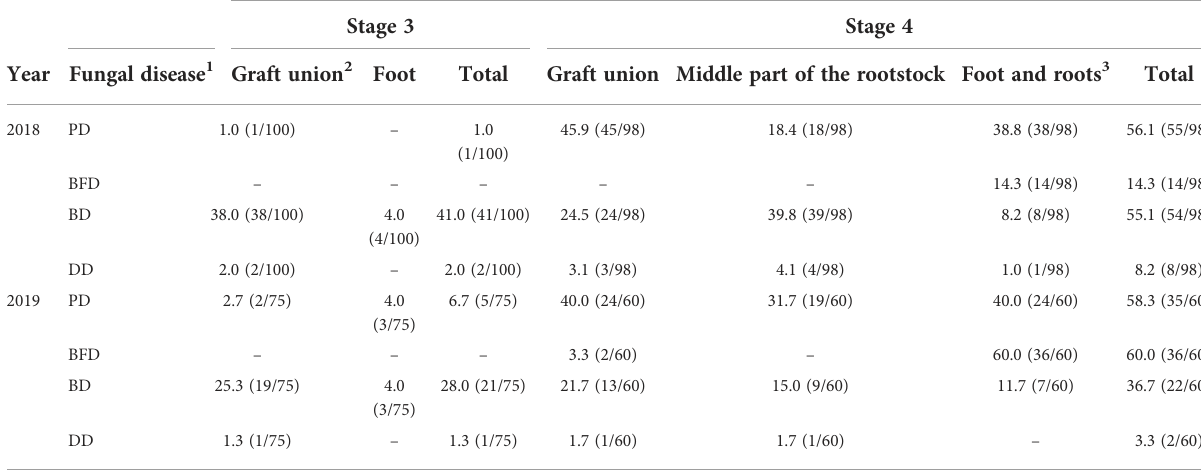
TABLE 3 Incidence of fungal grapevine trunk diseases in grafted plants after callusing (stage 3) and in rooted grafted plants (stage